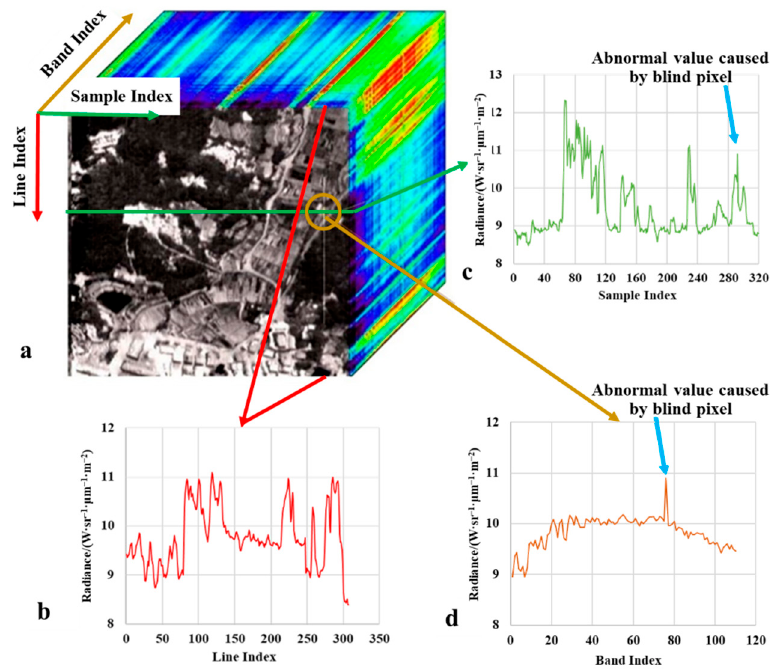
Figure 7. Thermal infrared hyperspectral data cube before blinking pixel repair. ( a ) data cube. ( b ) profile of along the line. ( c ) profile of along the sample. ( d ) spectrum of a specific pixel.